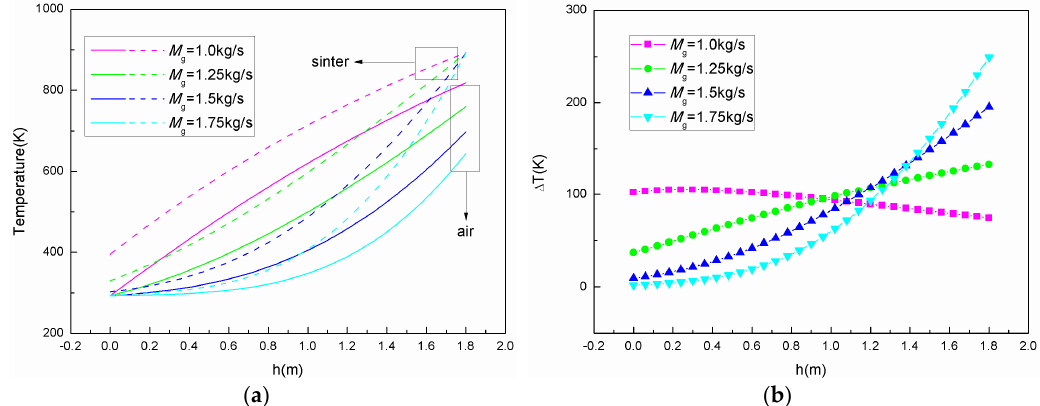
Figure 6. ( a ) The average cross-sectional temperature distribution of the air and sinter; ( b ) the temperature differences between the sinter and air along the height of the sinter bed layer for different air flow rates.